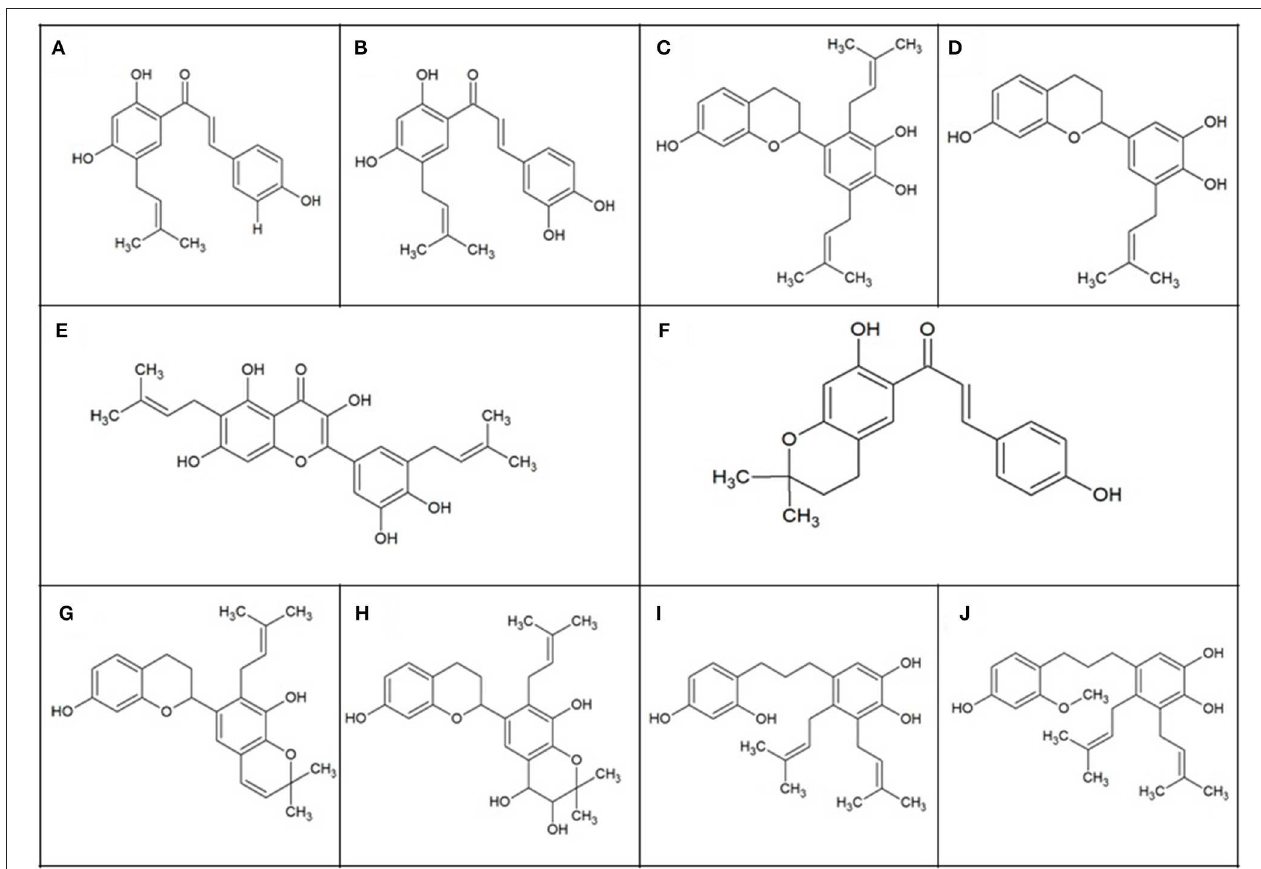
FIGURE 3 | Polyphenols isolated from Brussonetia papyrifera . (A) Broussochalcone B (C 20 H 20 O 4 ); (B) broussochalcone A (C 20 H 20 O 5 ); (C) kazinol A (C 25 H 30 O 4 ); (D) 3’-(3-methylbut-2-enyl)-3’,4,7-trihydroxyflavone (C